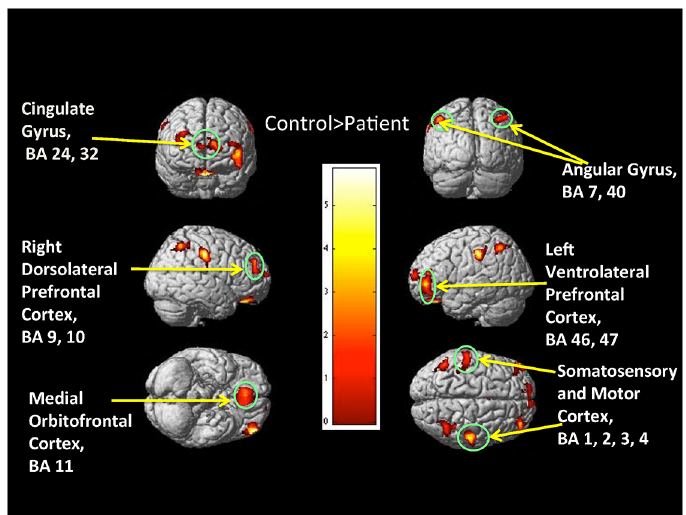
Fig 1. Whole brain VBM analyses: Controls > Patients. The 3D color map showing various frontal and parietal regions where Controls > Patients. Color bar represents t-value.